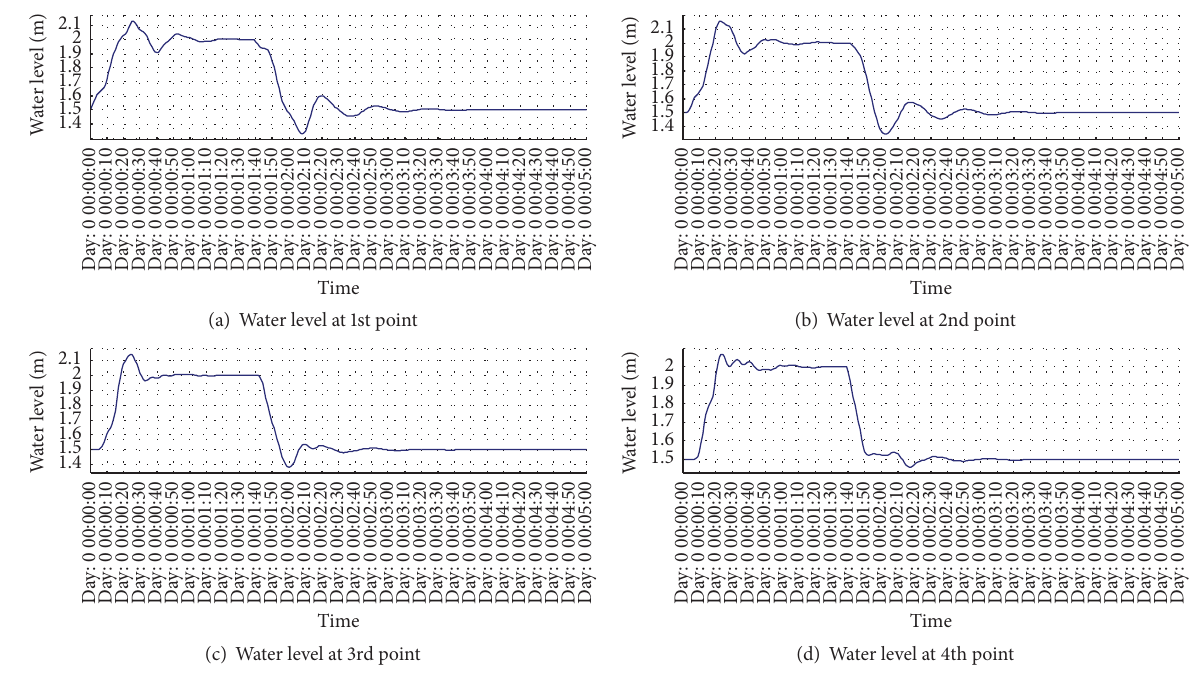
Figure 12: Evolutions of water levels at four points in pool 2 with 𝑁 = 𝑀 = 60